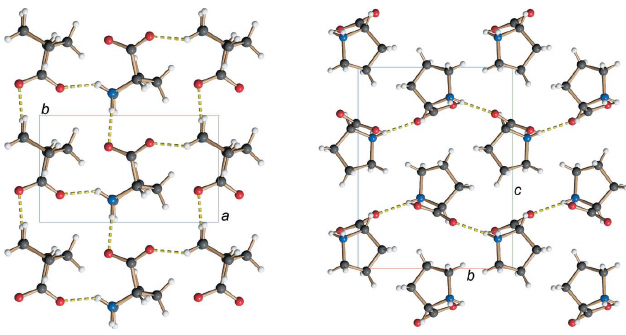
Figure 2 View along the c axis (left) and the a axis (right) showing that l -proline forms layers through hydrogen bonding between the carboxylic group O1 respectively O2 and amine N1.